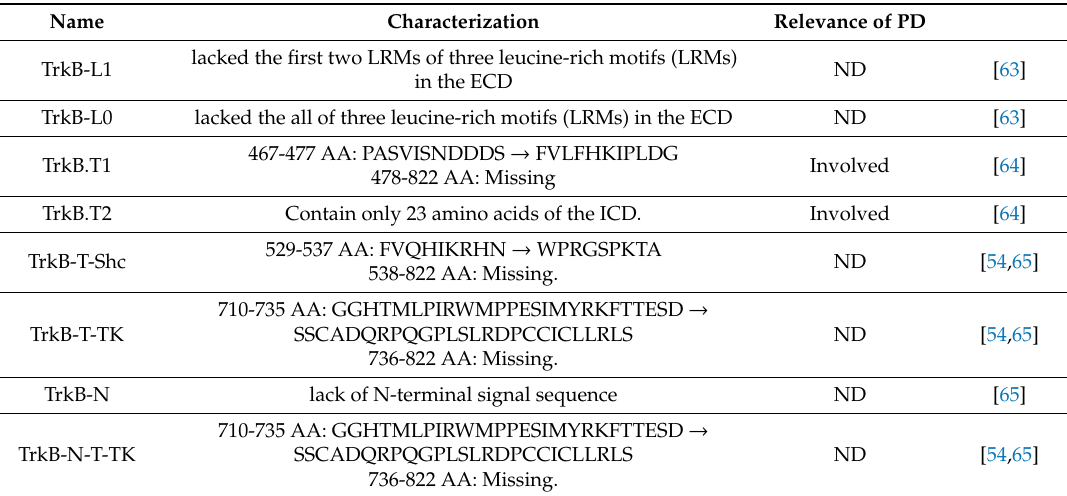
Table 1. Characterization of TrkB